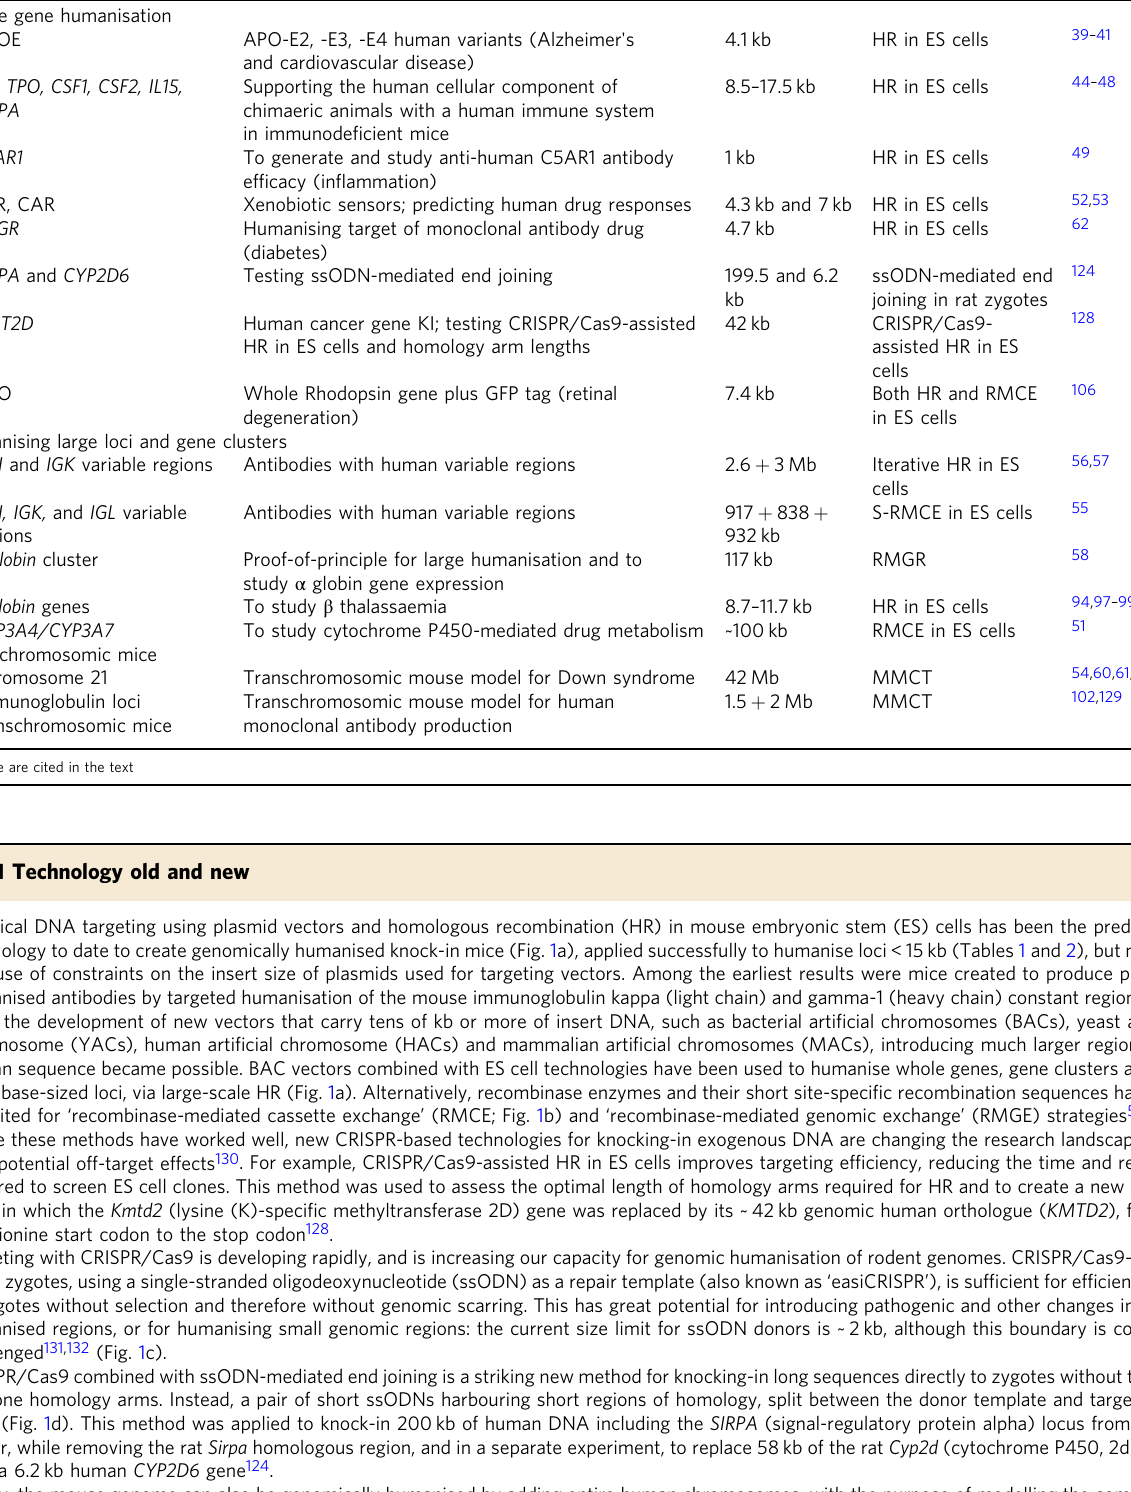
Table 2 Examples of whole gene and larger-scale genomically humanised mice created for different investigations Human